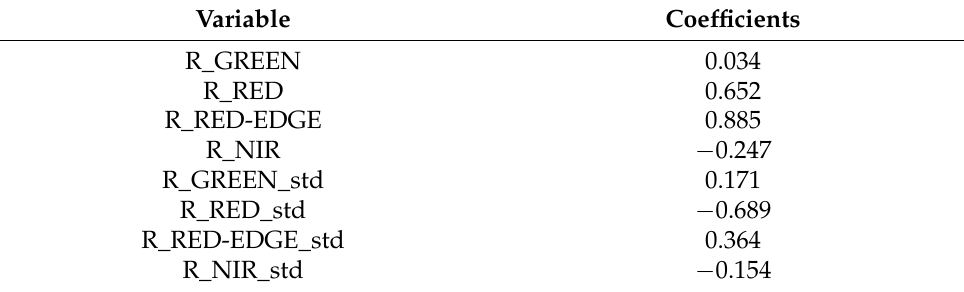
Table 9. Within-class standardized coefficients of the canonical